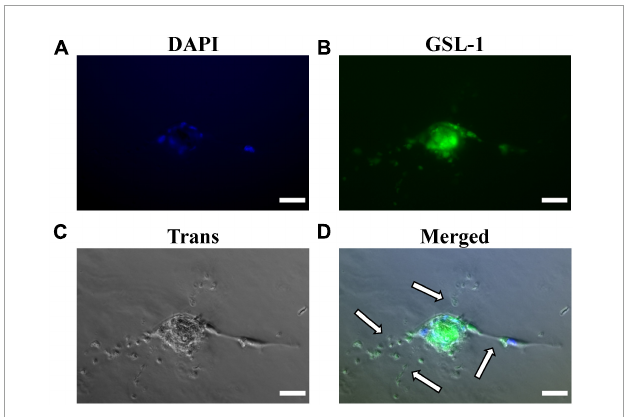
FIGURE5 Matrigel embedded capillary sprouting capacity and Griffonia Simplicifolia Lectin-IB4 IF-staining of isolated MRPECs 10 days post-isolation. Representative phase-contrast photomicrographs and IF-images of MRPECs embedded in a Matrigel assays 36 h after Griffonia Simplicifolia Lectin-IB4 (GSL-1) staining and implantation. (A) Nuclear staining, DAPI (blue), (B) GSL-I staining (green), (C) phase-contrasted photomicrograph of embedded MRPECs (gray), and (D) overlay (merged); white arrows indicate capillary spouts/tubes. All representative images were taken at 20 × magnification. All images were obtained on an EVOS-M5000 fluorescence microscope system and merged by overlay in FIJI (ImageJ) software. N = 4 isolations. Scale bars, 50 µ m